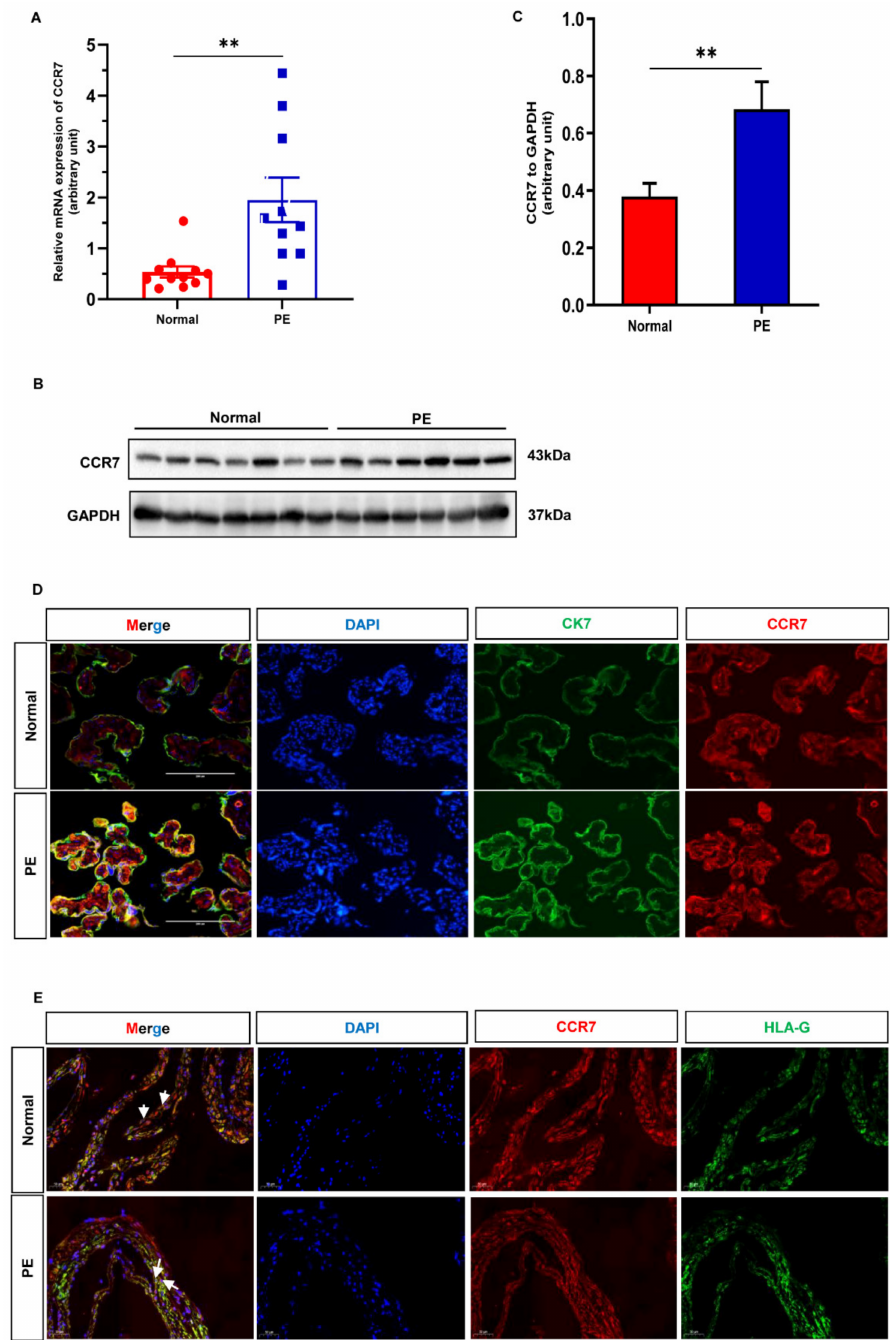
Figure 2. CCR7 expression and localization in human placental tissues and the decidual. ( A ) The transcriptional expression level of CCR7 was analyzed by qRT-PCR in human placental tissues from normal pregnancies ( n = 11) and PE patients ( n = 10). ( B ) Western blotting analysis of CCR7 protein expression level in normal ( n = 7) and PE ( n = 7) placenta tissues (Supplementary File S1). ( C ) Statistical analysis of protein densitometry quantification in Figure 2B. ( D , E ) Double-stained immunofluorescence analysis of CCR7 distribution in the placental and decidual tissues from normal pregnancies and PE patients. Scale bars-200 µ m and 50 µ m, respectively. The CK7-labeled trophoblast cells and HLA-G-labeled EVT cells are indicated by green signals. The CCR7 protein is indicated by red signals; ** p <